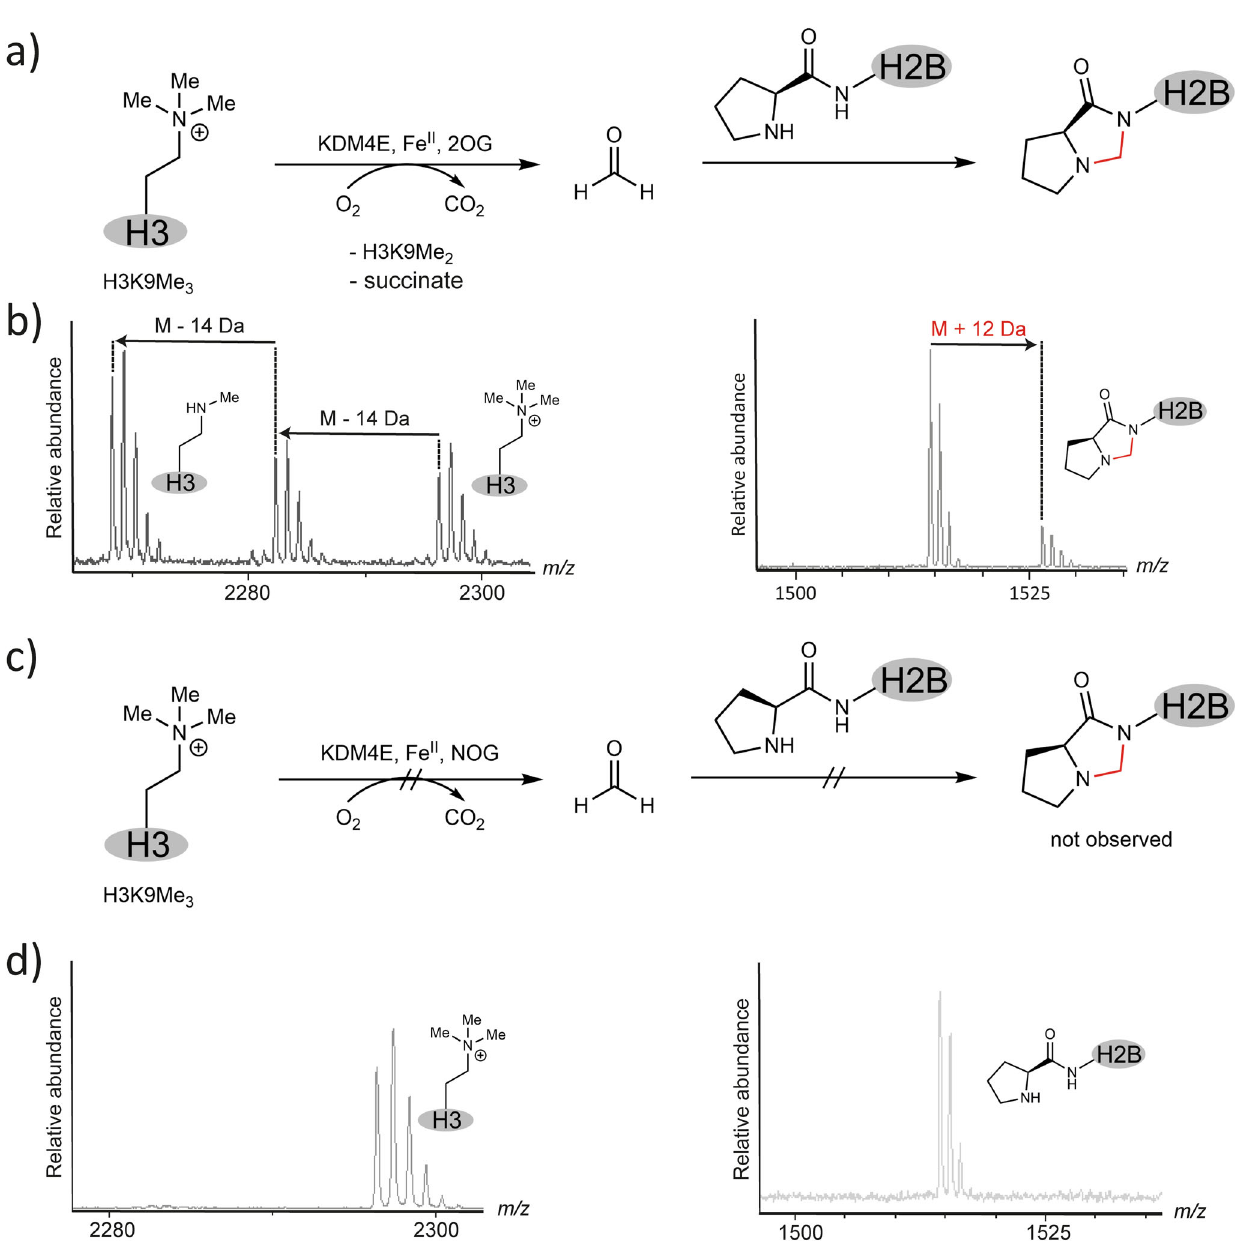
Fig. 2 In situ-generated HCHO by a demethylase reacts with H2B to form a + 12 Da adduct. a Formation of a + 12 Da adduct derived from the H2B N-terminal proline and HCHO produced during KDM4E-catalysed N ε -methyllysine demethylation. MALDI MS spectra showing demethylation of H3K9Me 3 21mer peptide (2296 Da) to form dimethylated (2282 Da, M-14 Da) and monomethylated (2268 Da, M-28 Da) products in the presence of 2-oxoglutarate (2OG) and KDM4E (24 h incubation) ( b , left panel), indicative of HCHO formation. With H2B in the reaction mixture, the H2B 15mer peptide reacts with the KDM4E-generated HCHO (24 h) to form a + 12 Da HCHO-derived adduct in the presence of 2OG, the co-substrate of KDM4E ( b , right panel). Na + adducts of the parent peptide [1514 Da] and HCHO-adduct [1526 Da, M + 12 Da] are observed. c , d In the presence of N -oxalylglycine (NOG), a broad- spectrum 2OG-oxygenase inhibitor, demethylation is inhibited and less HCHO is formed and no reaction with H2B is observed ( d , right